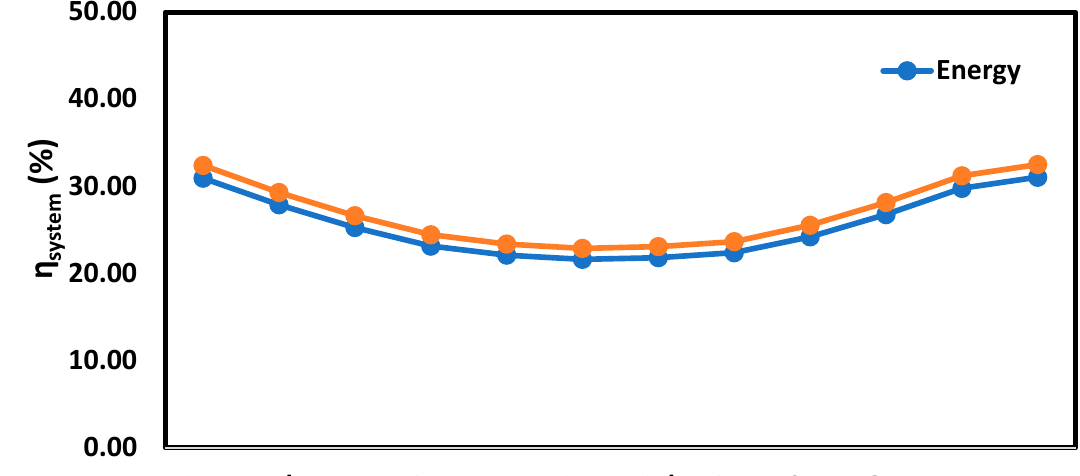
Figure 11. Monthly average of energy and exergy efficiencies of the GT + HRSG + HSR system considering solar radiation.